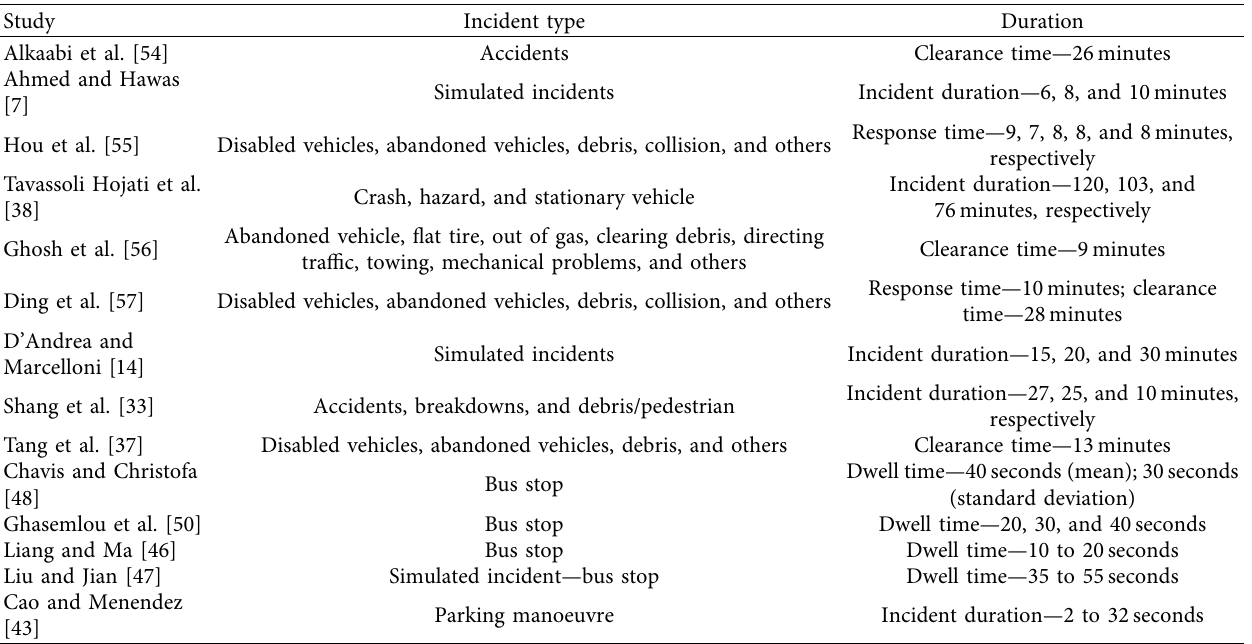
Table 1: Studies on incident types and duration time